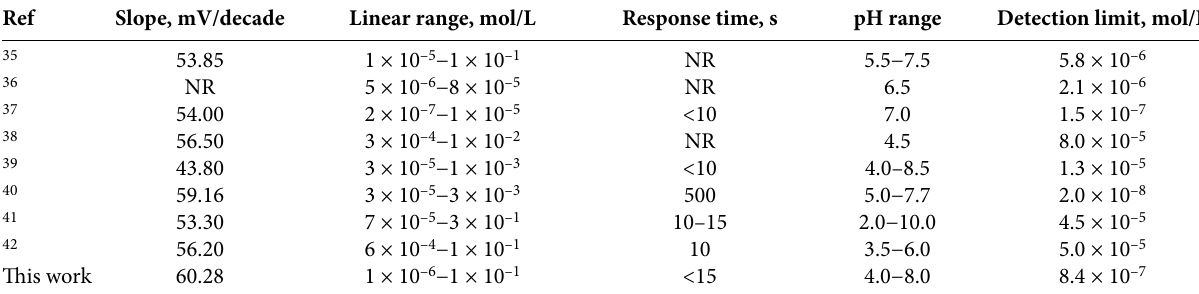
Table 4. Comparation of the DOP-selective microsensors in the literature Ref Slope, mV/decade Linear range,